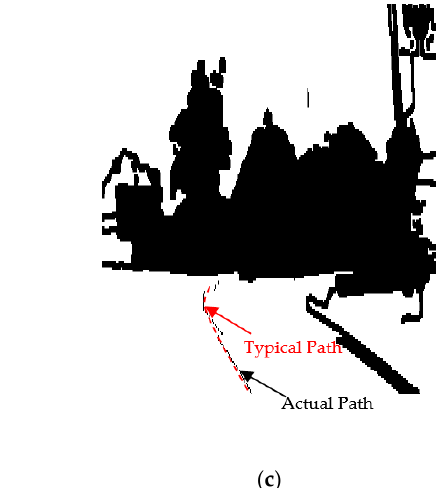
(with 5 m as width and 500 m as length) with a car on the side / in front: ( a ) original image, ( b ) image 5 m as width and 500 m as length) with a car on the side/in front: ( a ) original image, ( b ) image processing, and ( c ) generation of the path within the road following environment.